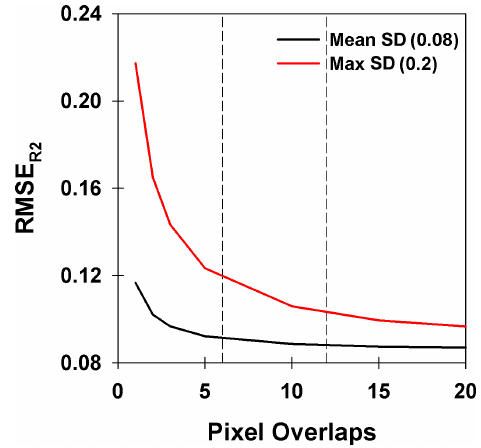
Figure 2. The root-mean-square error of RADARSAT-2 peak melt pond fraction values (RMSE R 2 ) with increasing number of RADARSAT-2 pixel overlaps. The vertical dashed lines indicate the range of typical overlap from